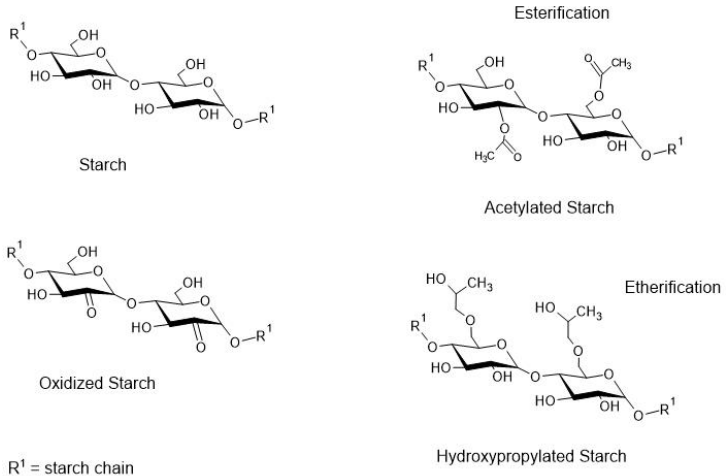
Figure 4. Representation of modified starch.